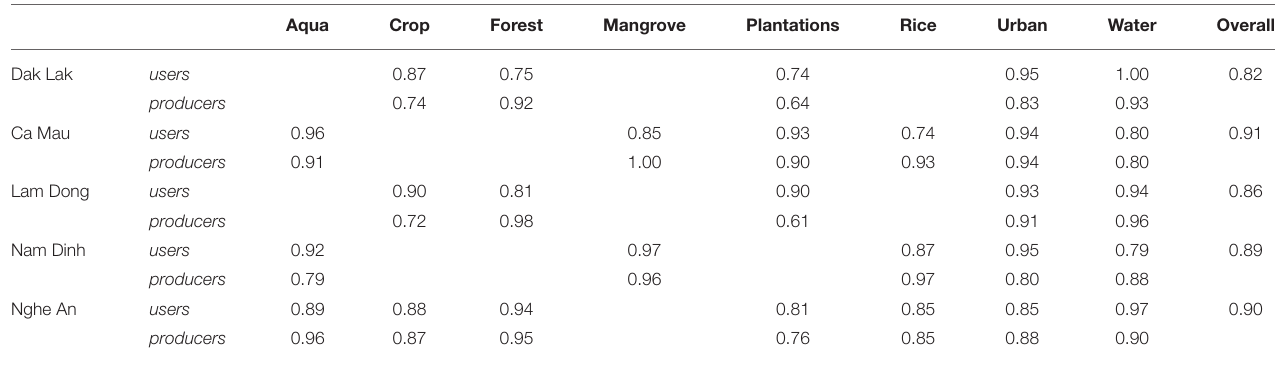
TABLE 4 | Overall user and producer accuracy for each